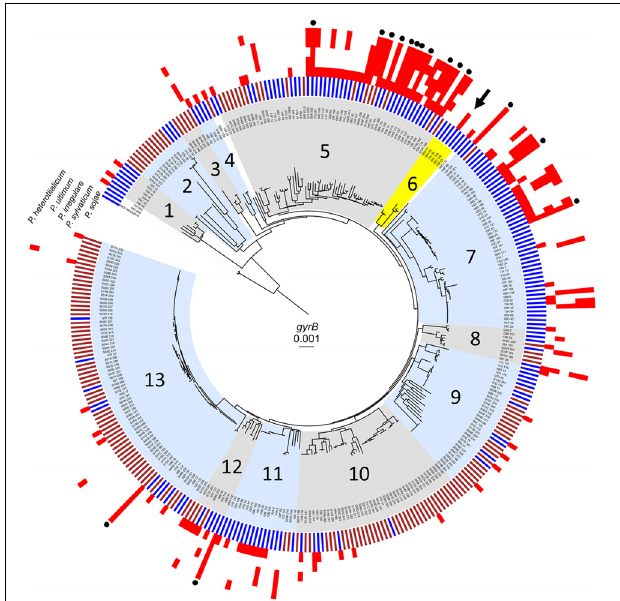
FIGURE 1 | Population-level diversity and antagonistic activity among pseudomonads. Neighbor-joining phylogenetic tree based on partial sequence of the gyrB gene for 330 strains (Chatterjee et al., 2017), overlaid with data for habitat (inner bars: brown, soil; blue, water). 163 strains were isolated from the Central Basin of Lake Erie and 167 were from soil in Bowling Green, OH, United States. Antagonistic activity against P. sojae , P. sylvaticum , P. irregular , P. ultimum , and P. heterothalicum is indicated by a red block. Strains that exhibit activity against all oomycetes are identified by a black circle on the outermost edge of the tree. Highlighted in yellow is population 6 which includes strain 06C 126 (black arrow).